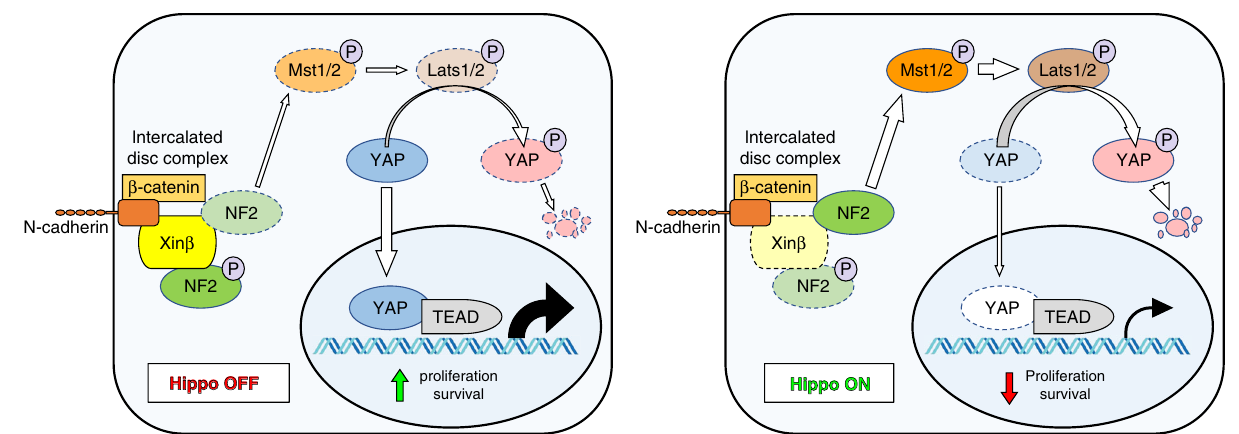
Fig. 5 Model of Xin β regulation of the Hippo-YAP signaling pathway in cardiomyocytes. Xin β negatively modulates Hippo-YAP signaling by recruiting phosphorylated NF2 to the sarcolemmal membrane of cardiomyocytes, leading to the reduction of total NF2 protein, repression of Hippo signaling, and the activation of the downstream mediator YAP (left panel). Loss of Xin β results in activation of Hippo signaling and a reduction of functional YAP levels, which reduces expression of